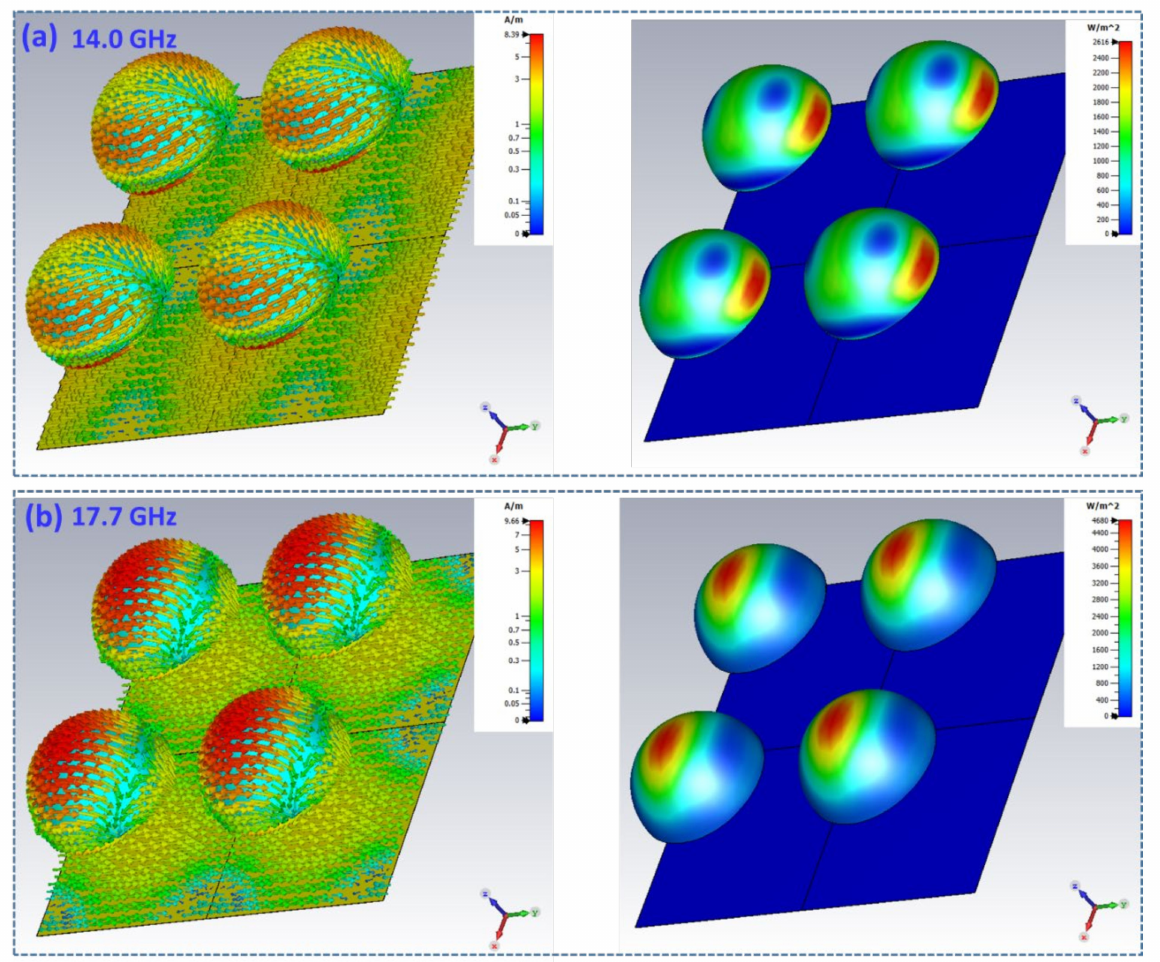
Figure 4. Figure distribution of the induced surface current ( left ) and surface loss density ( right ) for ( a ) 14.0 and ( b ) 17.7 GHz, in the case of the CD